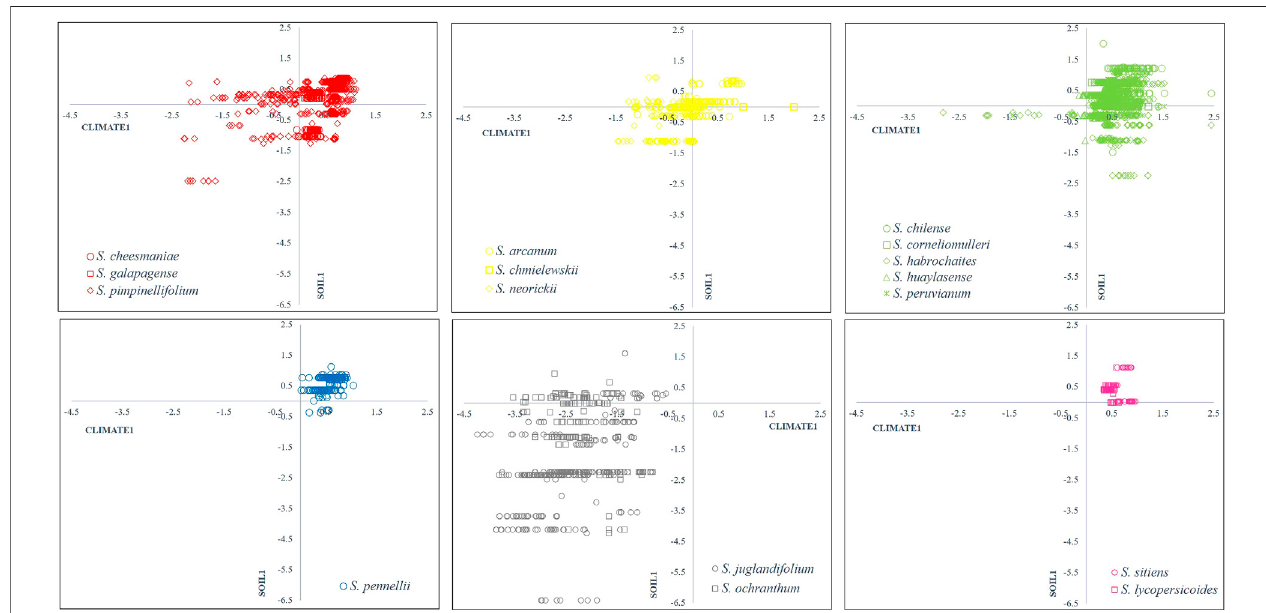
FIGURE 3 | Scatter plot of SOIL1 vs CLIMATE1 canonical vectors from CCA with 0.80 correlation and 74% of total variation. Group 1 (red): Section Lycopersicon: “ Lycopersicon group ” , Group 2 (yellow): “ Arcanum group ” , Group 3 (green): “ Eriopersicon group ” , Group 4 (blue): “ Neolycopersicon group ” outgroup close related species in Section Juglandifolia Group 5 (grey): and Group 6 (pink): Section Lycopersicoides. In each scatter plot fi rst-quadrant (I) represents environments with low annual evapotranspiration (ET), annual precipitation (Bio12), precipitation of driest month (Bio14) and high pH, BD, and base saturation (BS); second-quadrant (II) represents environments with high ET, Bio12, Bio14 and high pH, BD and BS; third-quadrant (III) represents environments with high ET, Bio12, Bio14 and low pH, BD and BS; fourth-quadrant (IV) represents environments with low ET, Bio12, Bio14, and low pH, BD, and